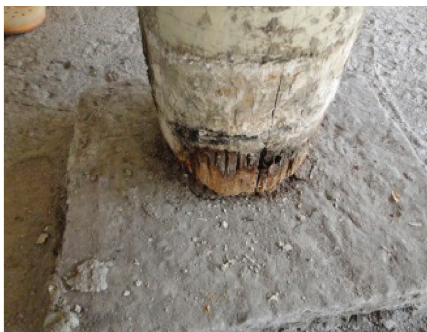
Figure 3: Circumferential column foot